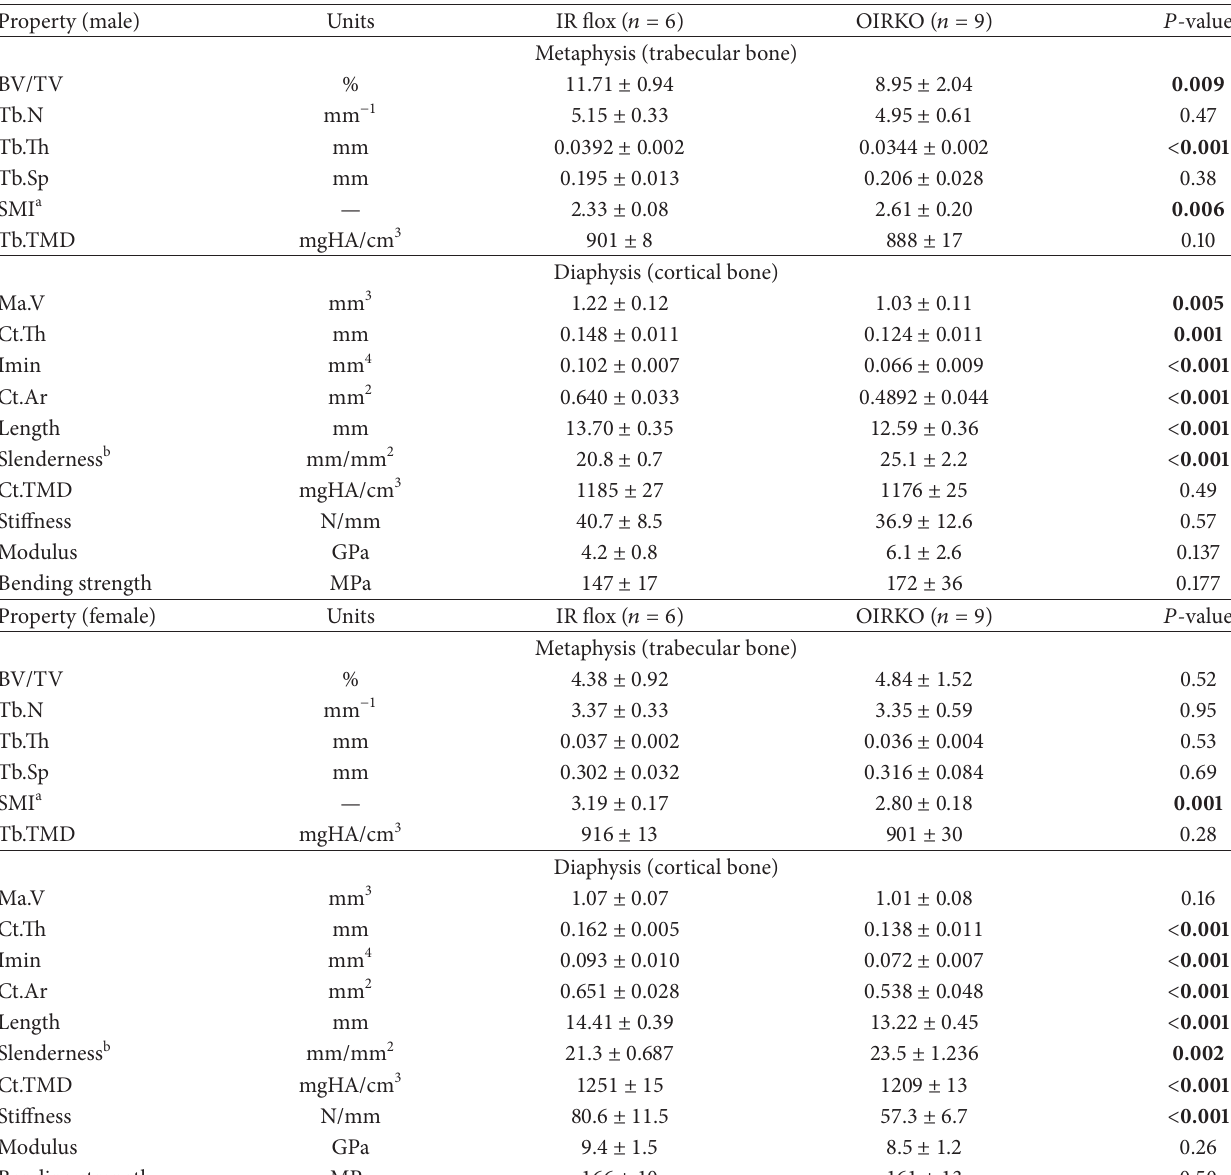
Table 1: Selected properties of bone, as determined by 𝜇 CT and three-point bending, for males (top) and females (bottom), comparing control (IR flox) and OIRKO